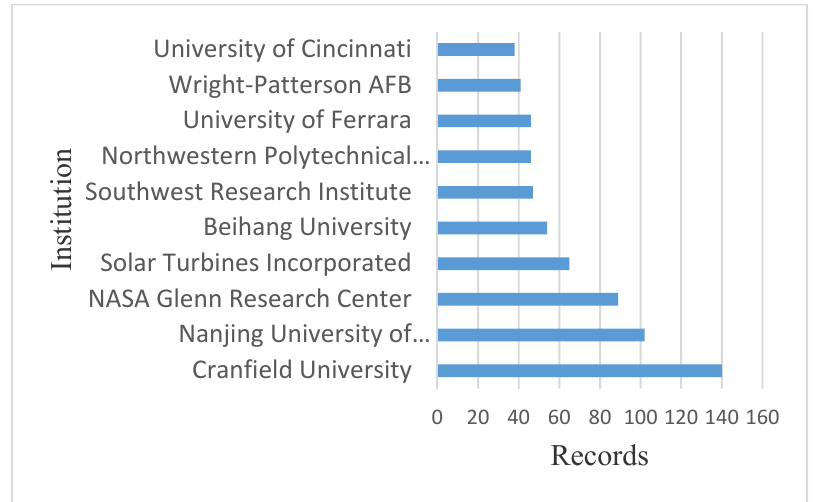
Figure 3. List of top 10 scientific institutes in terms of published articles.